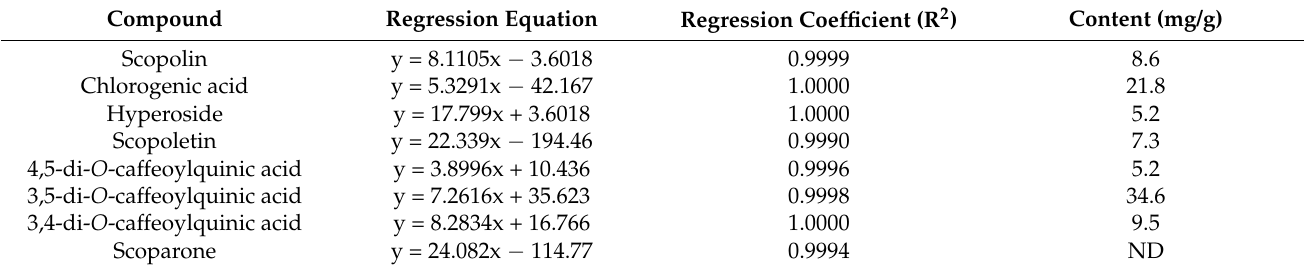
Table 1. The quantification of seven components in Artemisia gmelinii